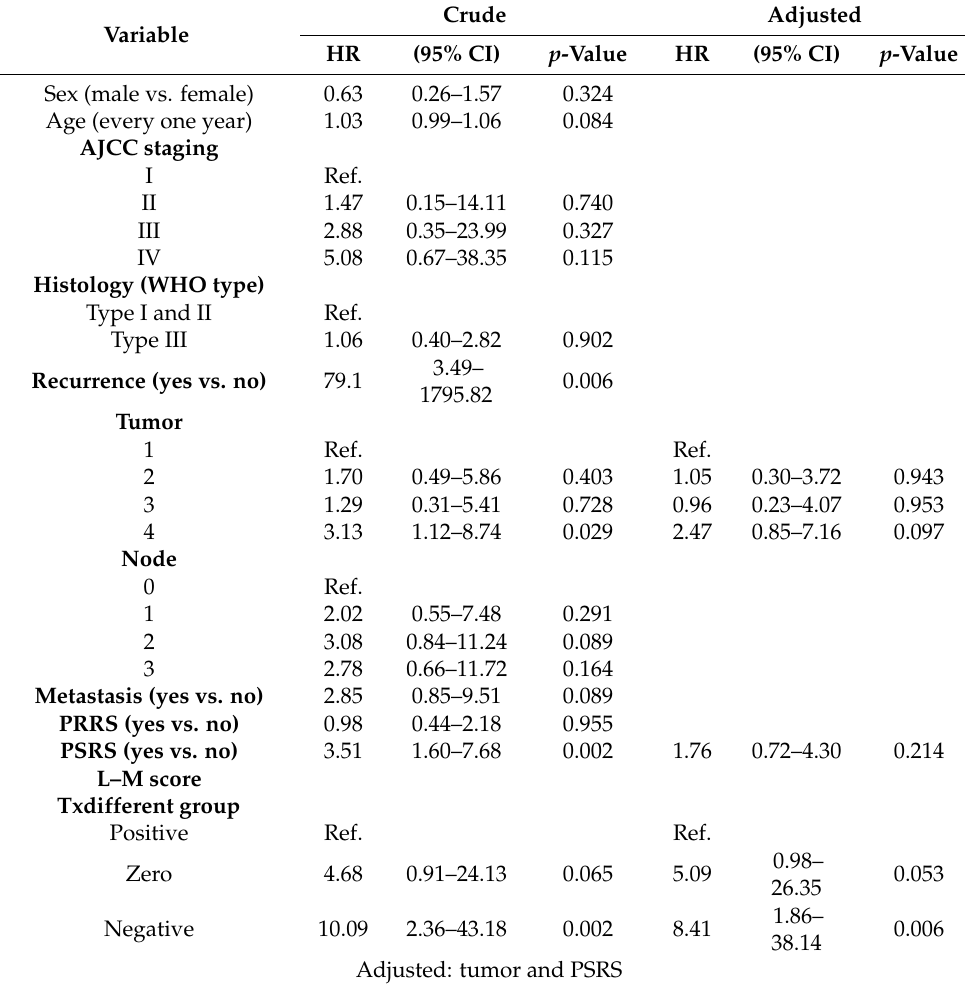
Table 2. Hazard ratio and 95% confidence interval of